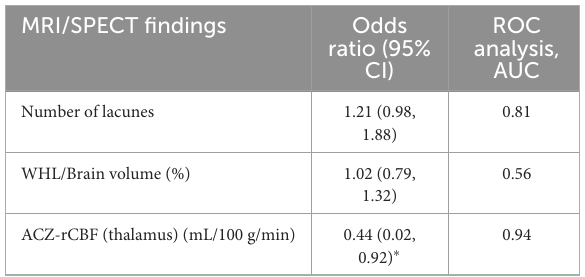
TABLE 3 Univariate logistic regression analysis of MRI/SPECT findings in association with the recurrence of stroke or critical event